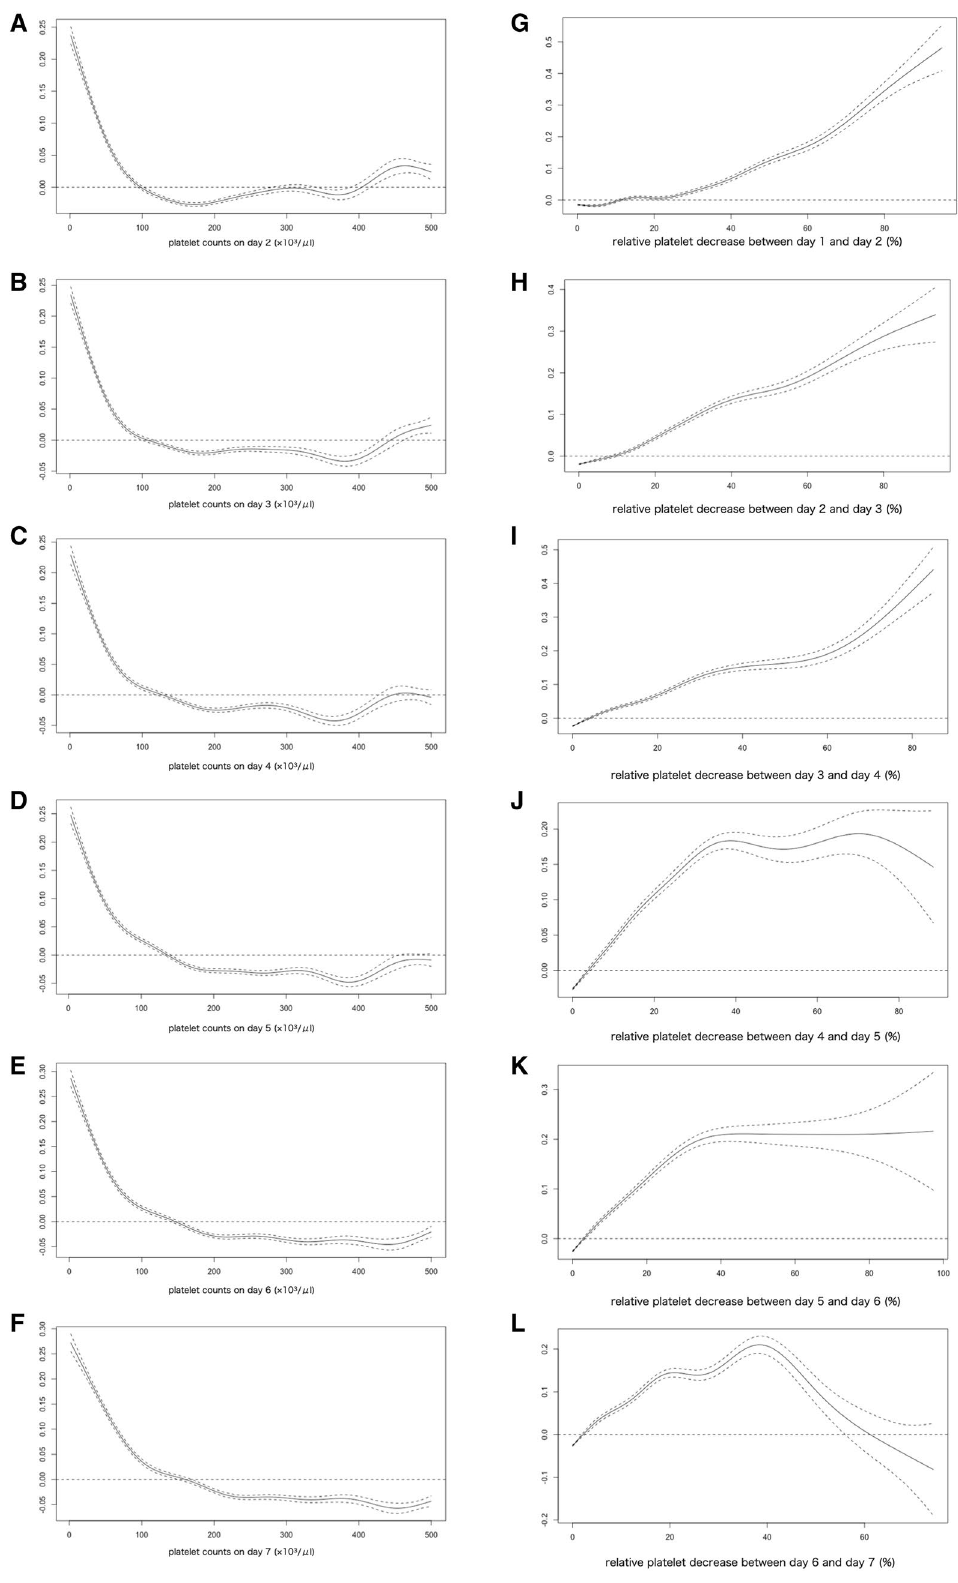
Figure 3. The result of spline regression analysis. ( A – F ) the estimated spline function in log odds ratio on the effect of absolute platelet counts on in-hospital mortality. ( G – L ) the estimated spline function in log odds ratio on the effect of relative platelet reductions on in-hospital